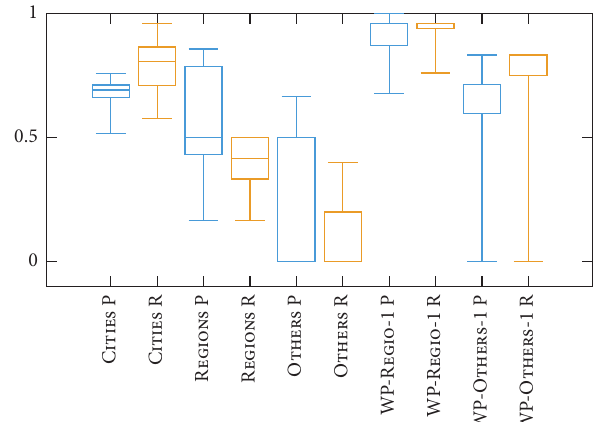
Figure 20: Boxplots of precision P and recall R values ( y -axis) induced by the measures of Table 5 underlying the F -scores of Table 7. Distributions are distinguished by the respective target class of the